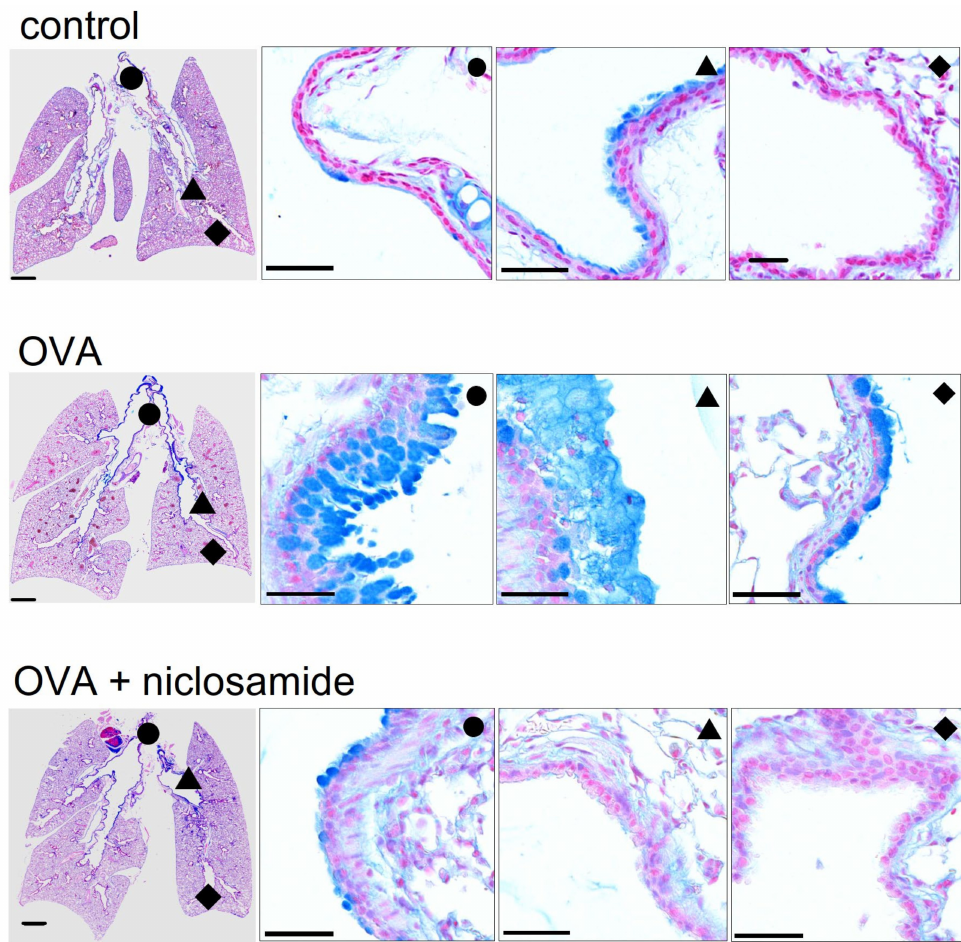
Figure 3. Mucus production and mucus secretion is inhibited by niclosamide. Whole mouse lung analysis by stitching microscopy. Low level mucus production and mucus secretion in proximal ( • ), central ( (cid:78) ), and peripheral ( (cid:7) ) airways of control mice. Bars = 1000 (very left panels) and 50 µ m (higher resolution panels), respectively. Pronounced upregulation of mucus production and intraluminal mucus accumulation in lungs of OVA-treated (asthmatic) mice. Mucus production and mucus secretion is strongly suppressed in asthmatic mice treated with niclosamide (13 µ g/mL, 4 days).